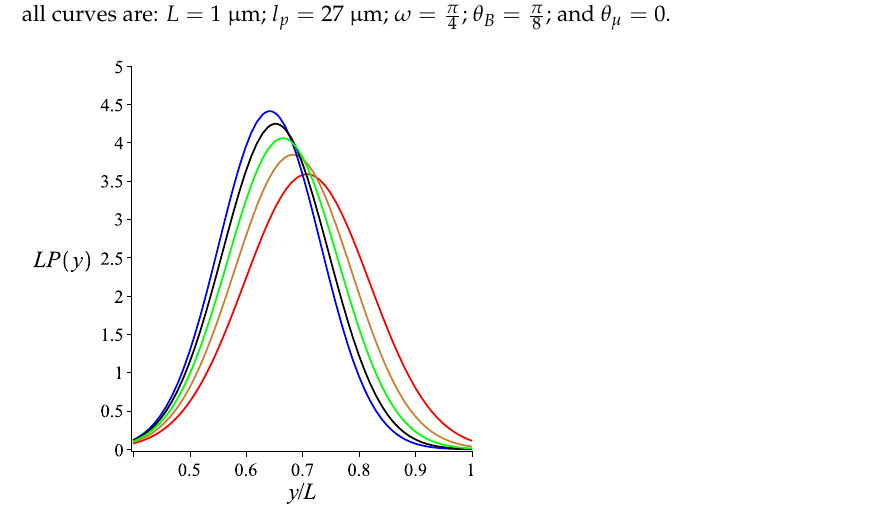
Figure 3. The probability density of the y coordinate of the position of the tip of a single grafted filament with a magnetic bead, as shown by Equation (7). The red, gold, green, black and blue colours correspond to K B = 0, K B = 3, K B = 6, K B = 9 and K B = 12, respectively. The fixed parameters for all curves are: L = 1 µ m; l p = 27 µ m; ω = π ; θ B = π ; and θ µ = 8 4